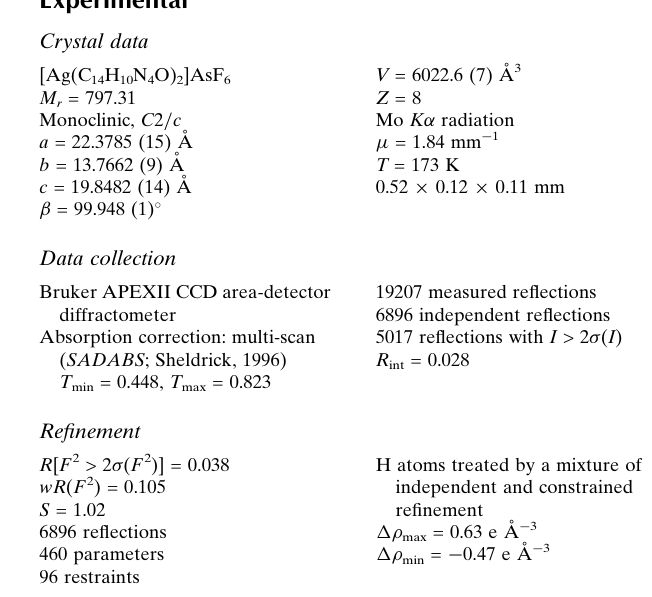
Data collection